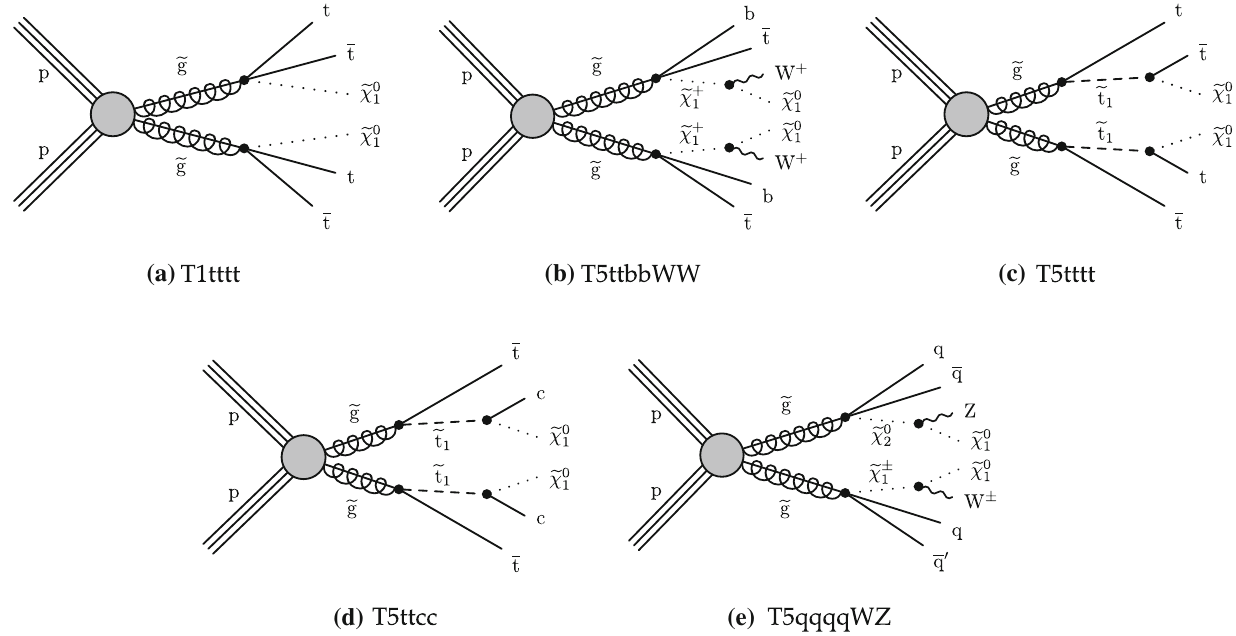
Fig. 1 Diagrams illustrating the simplified RPC SUSY models with gluino production considered in this